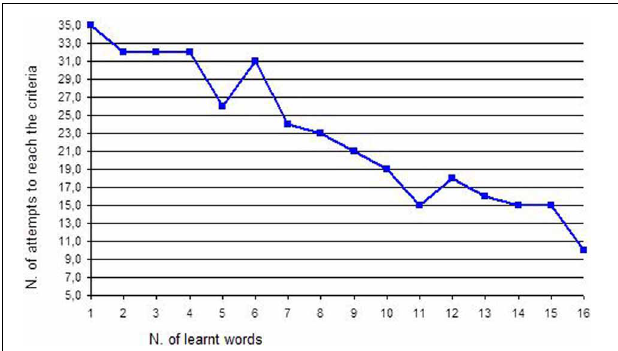
FIGURE 1 | Number of attempts to reach the criteria for each word.